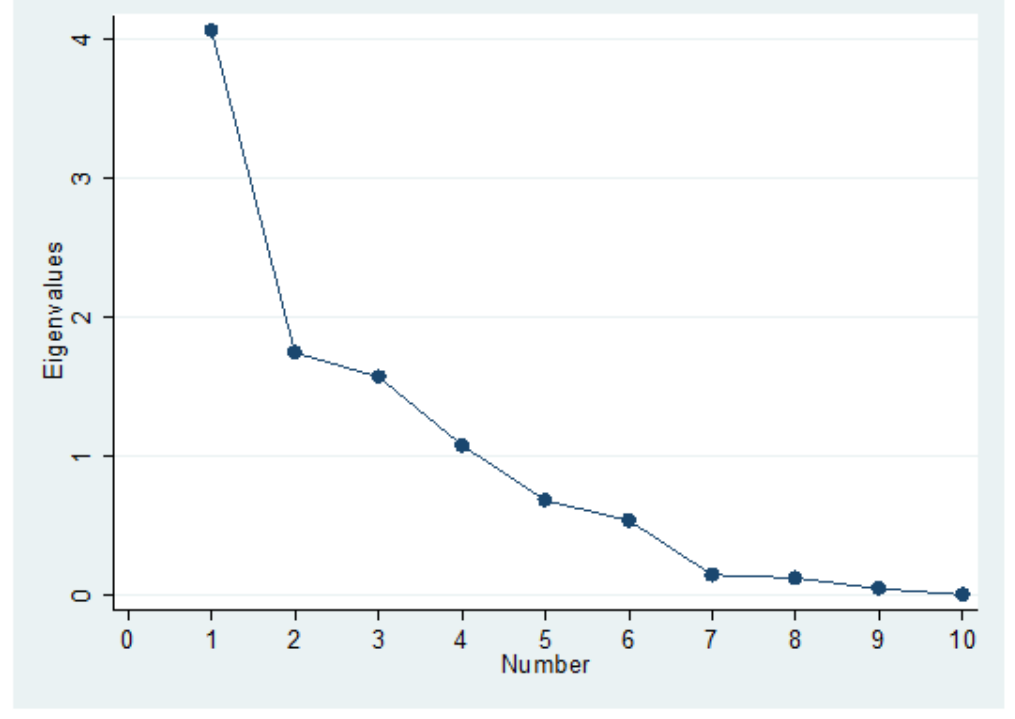
Figure 1. Principal Component Analysis Scree Plot